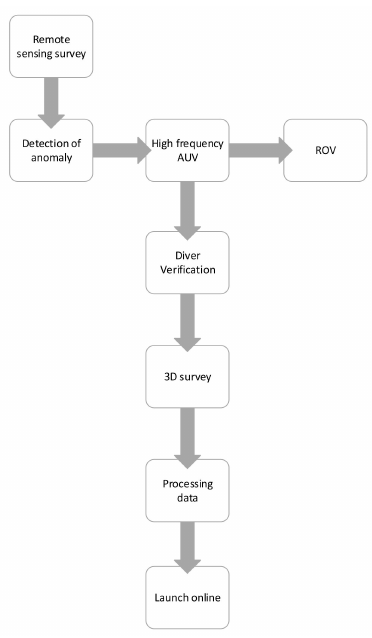
Figure 1. Schematic outlining the workflow for